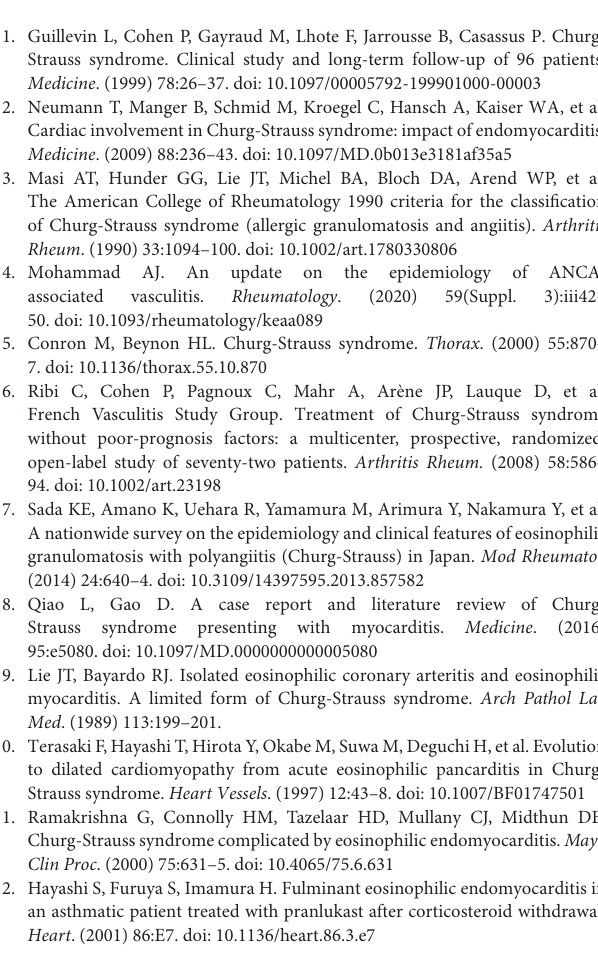
ejection fraction of